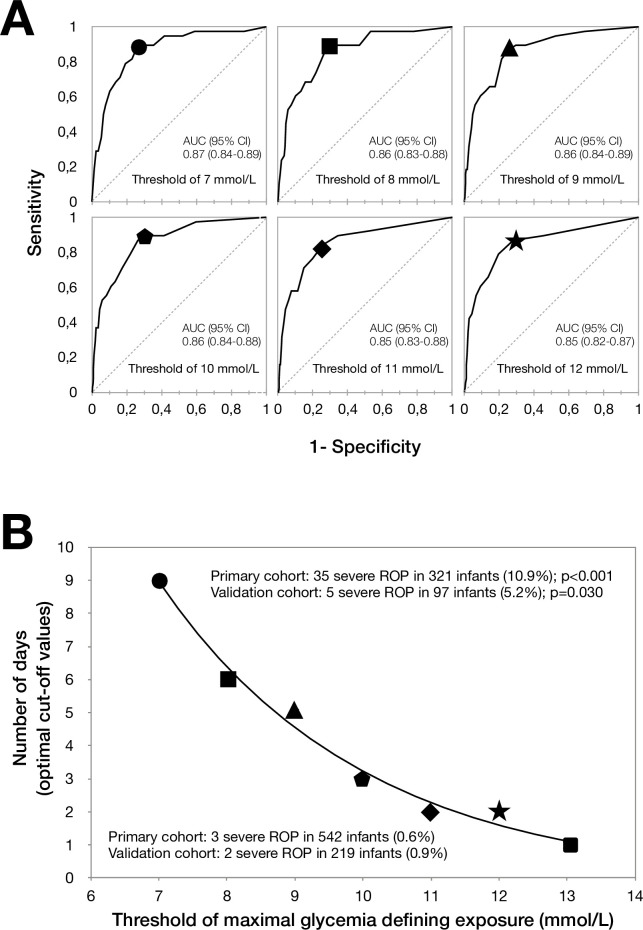
Thresholds of maximum glycemia and severe retinopathy of prematurity (ROP).(A) Shown are the receiver operating characteristic (ROC) curves of the duration (in days) with a maximum value of glycemia between birth and day 21 (MaxGly) above 7, 8, 9, 10, 11, and 12 mmol/l as related to severe ROP in the primary cohort. The areas under the curve (AUCs) for the ROC curves ranged from 0.85 (95% CI 0.79 to 0.92) for the duration above 13 mmol/l to 0.87 (95% CI 0.81 to 0.92) for the duration above 7 mmol/l, and were not significantly different (p = 0.700). Optimal cutoff values of the number of days above a given threshold of MaxGly were extracted from ROC curve analyses; they are represented by the different symbols. In (B), each optimal cutoff value is plotted versus the corresponding glucose value. Exposure above these cutoff values was significantly associated with increased risk of severe ROP after adjustment for gestational age in both the primary and validation cohorts.